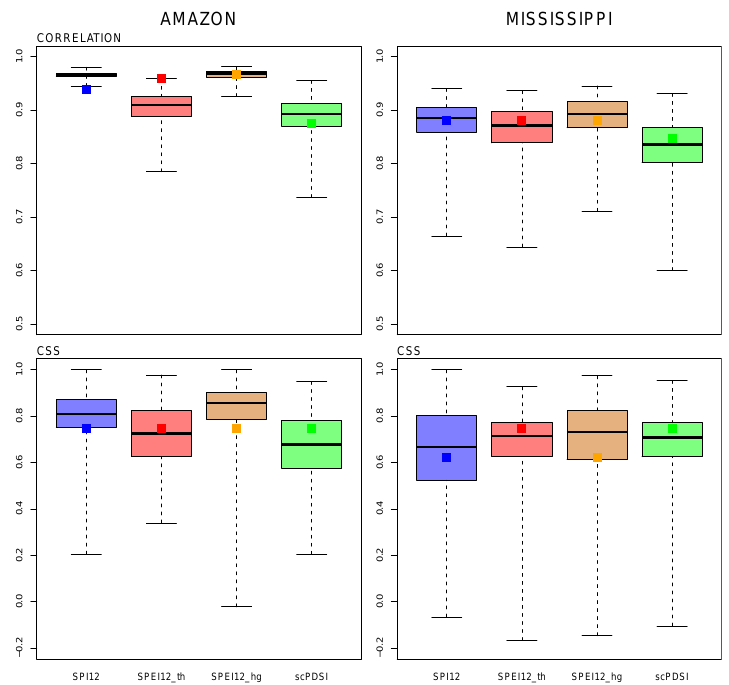
Fig. 2. Box-and-whisker plot of the sliding correlations and the CSS_20 calculated for the five members of the RCP8.5 scenario from 1850 to 2100 over a 49yr time span for the Amazon and Mississippi watersheds. The boxes represent the 25th and the 75th percentile, the line the mean value, and the whiskers the minimum and the maximum values of the ensemble spread. The smaller squares indicate results obtained from observations